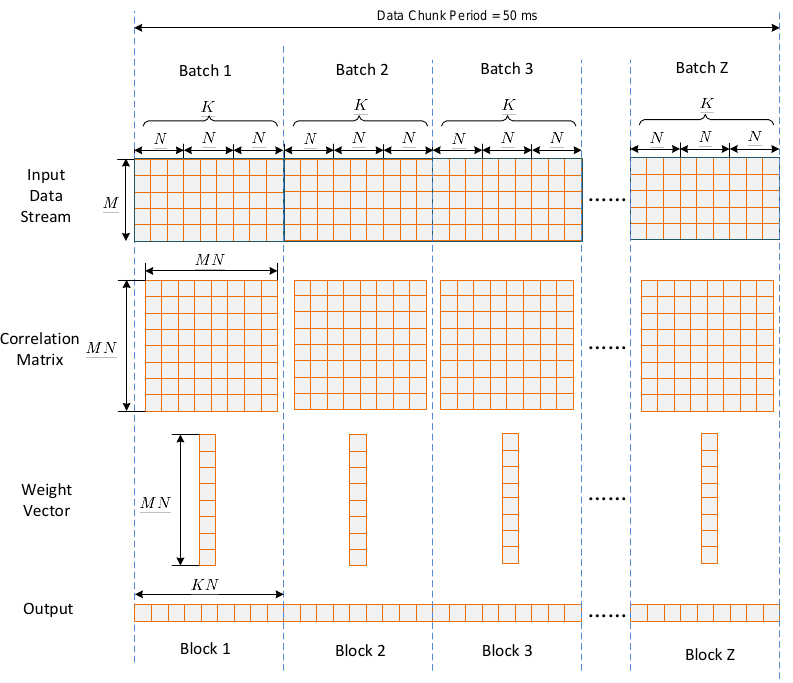
Figure 6. The batched implementation of STAP.